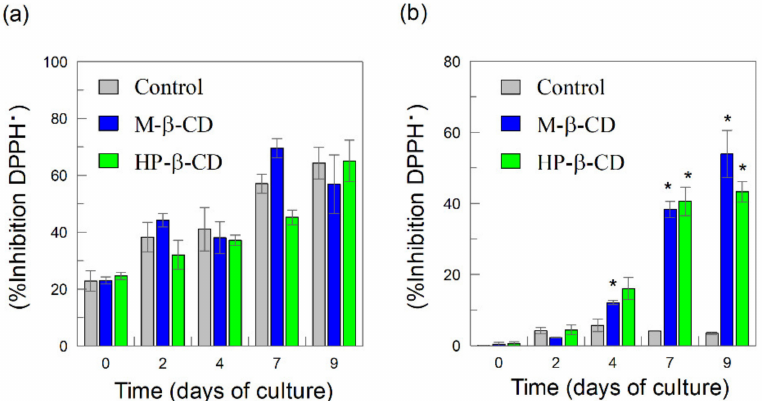
Figure 4. Radical scavenging activity (RSA) of intracellular ( a ) and extracellular ( b ) fractions from B. × houghtonii suspension cultured cells (BHSCC) in the absence (control) and in the presence of cyclodextrins (CDs). RSA values are expressed as %Inhibition (Equation (3), Section 3.9), [CD] = 50 mM at T = 25 ± 1 ◦ C. Values are given as the mean ± SD of triplicates and (*) refers to significant di ff erences between control and treatments for each day ( p <